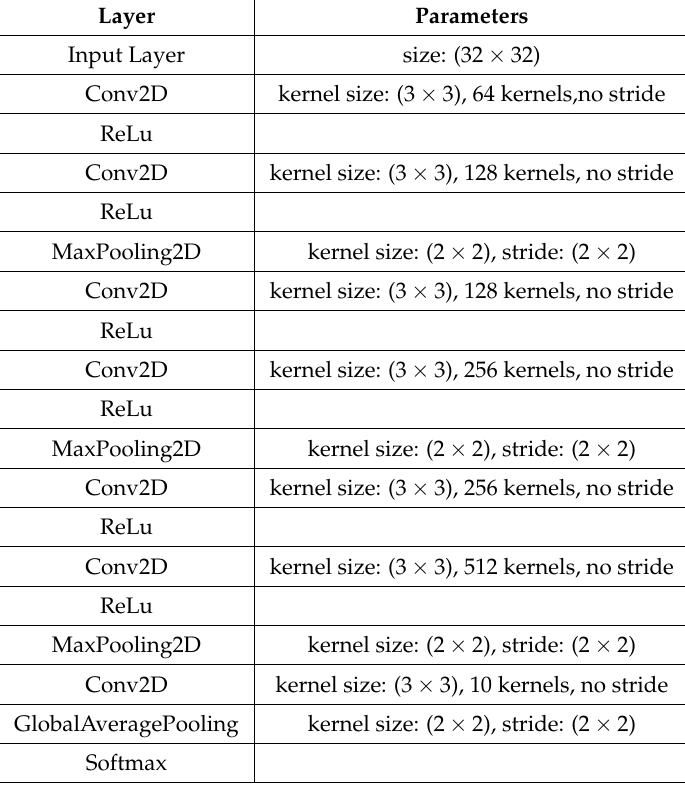
Table A2. Architecture of the used NNC on CIFAR-10 Layer